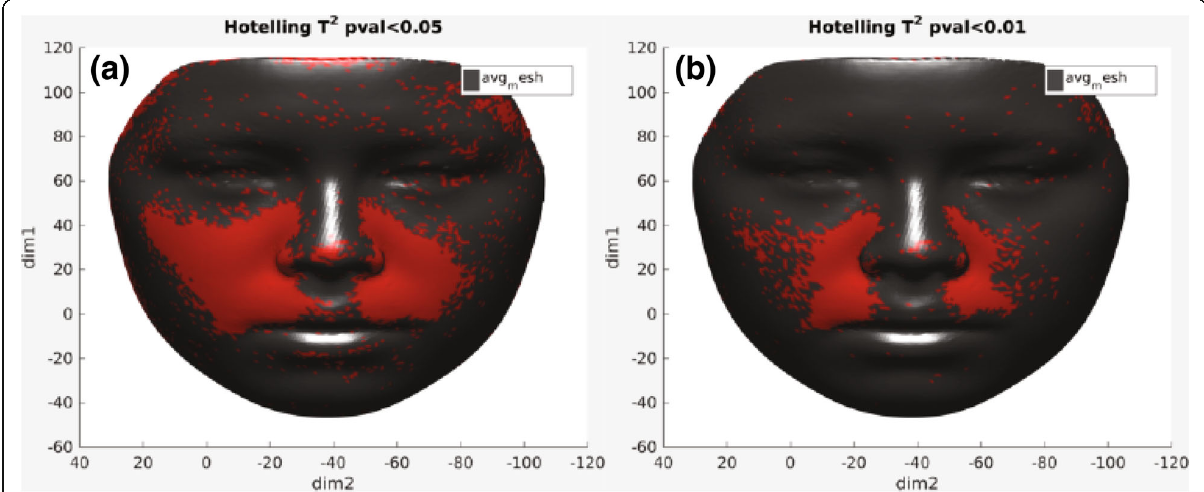
Fig. 6 P-map illustration for comparison of T0 (initial, right before MSE placement) – T1 (immediately after expansion) time points with p < 0.05 ( a ) and p < 0.01 ( b